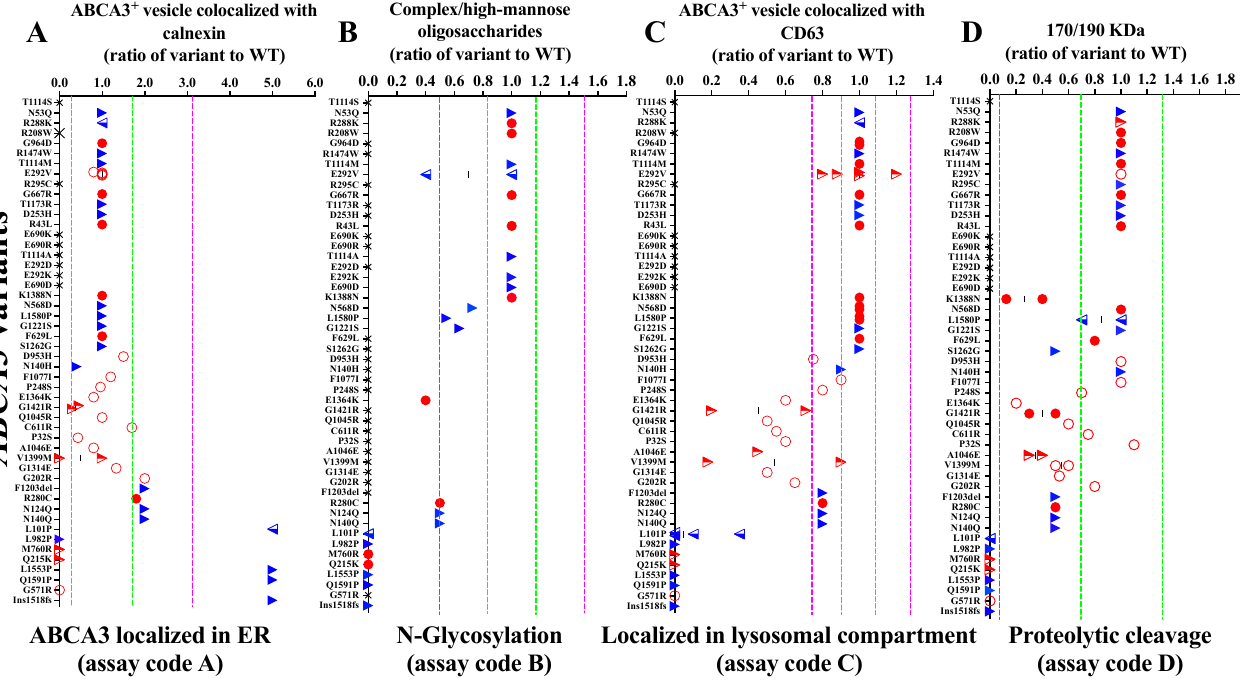
Figure 2. Data on the intracellular trafficking of ABCA3 variants: ( A ) localized in ER; ( B ) N- glycosylation; ( C ) localized in lysosomal compartments; ( D ) proteolytic cleavage. The green, dotted lines stand for ±1 nSD (fraction of WT nt). The purple, dotted lines stand for ±3 nSD (fraction of WT nt). The red, hollow circles represent data from this study. The red, solid circles represent data from our previous experiments. The red, semi-hollow triangles represent data from this study and the literature. The blue, semi-hollow triangles represent data from our previous experiments and the literature. The blue, solid triangles represent data from the literature. The black crosses represent that assays were not performed. Dark-grey shadow represents defective trafficking. The light-grey shadow represents impaired trafficking. No shadow represents normal trafficking. The assay code refers to Figure 1.